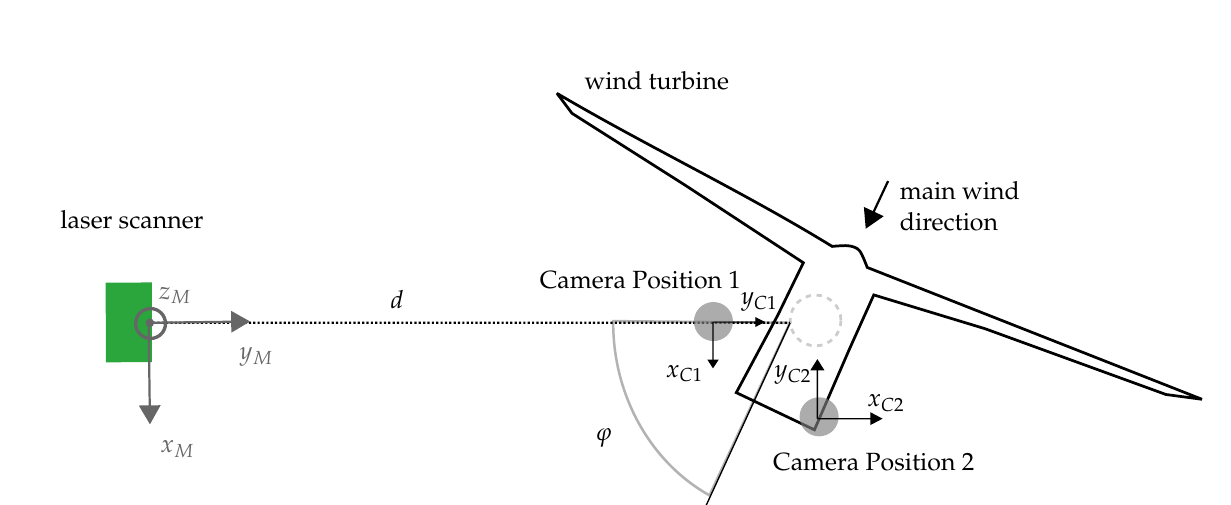
Figure 6. Top view of the measurement arrangement with horizontal laser scanning alignment and the measurement angle ϕ . The camera was placed either in Camera Position 1 or in Camera Position 2 depending on the main wind direction.